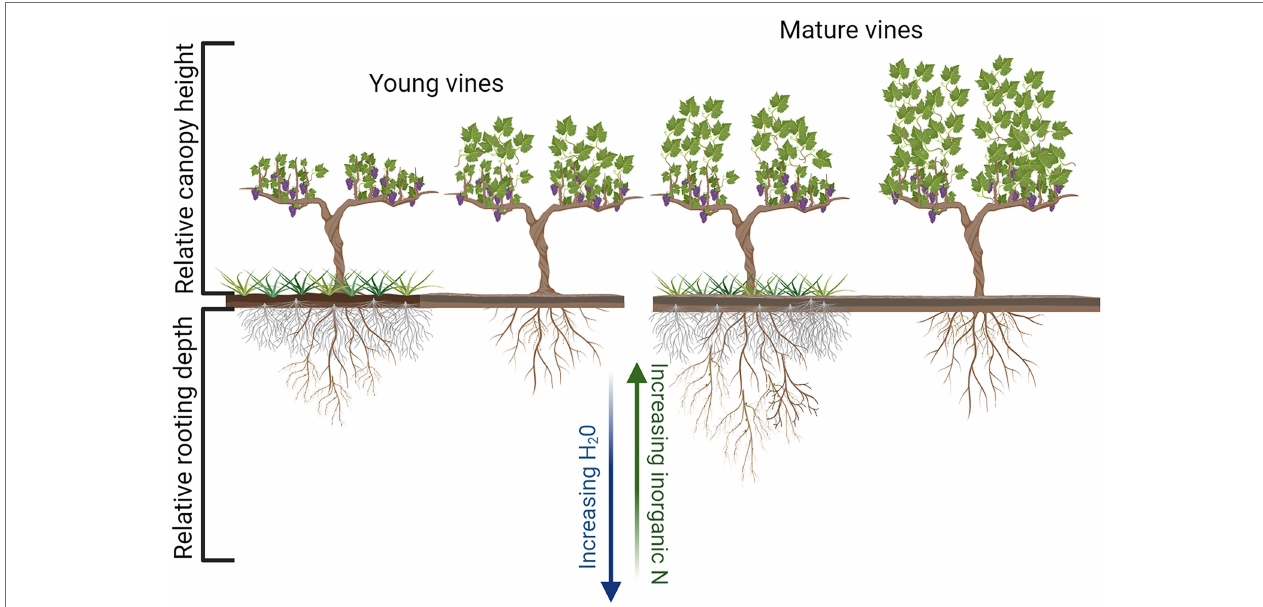
FIGURE 2 | Diagrammatic representation of the impact of soil management, UVV vs. bare soil, on relative canopy height and rooting depth of both young and mature grapevines. Figure created with